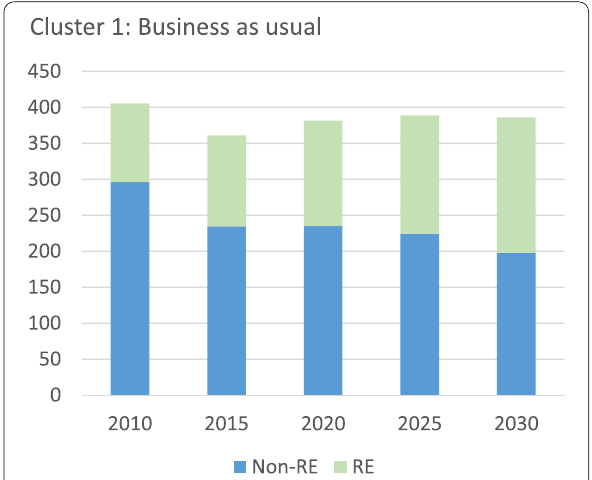
Fig. 4 Total consumption of energy between 2010 and 2030 in ‘BAU’ scenario (N.B. the total consumption was 378 TWh in 2019; years 2010